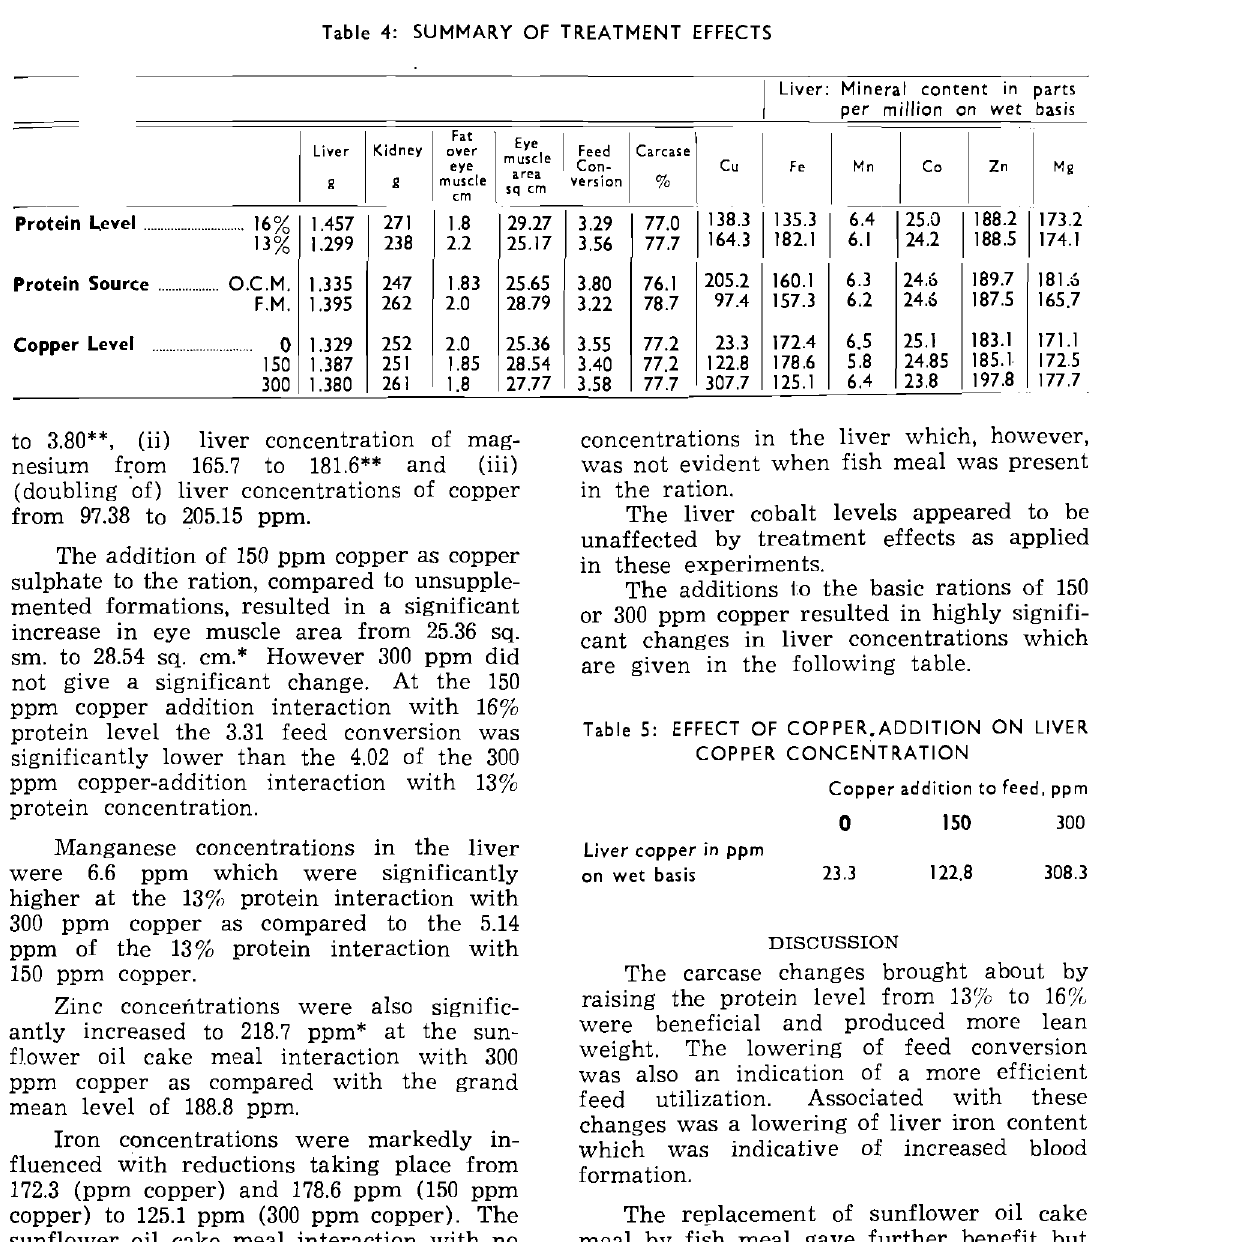
I Liver: Mineral content in parts per million on wet basis